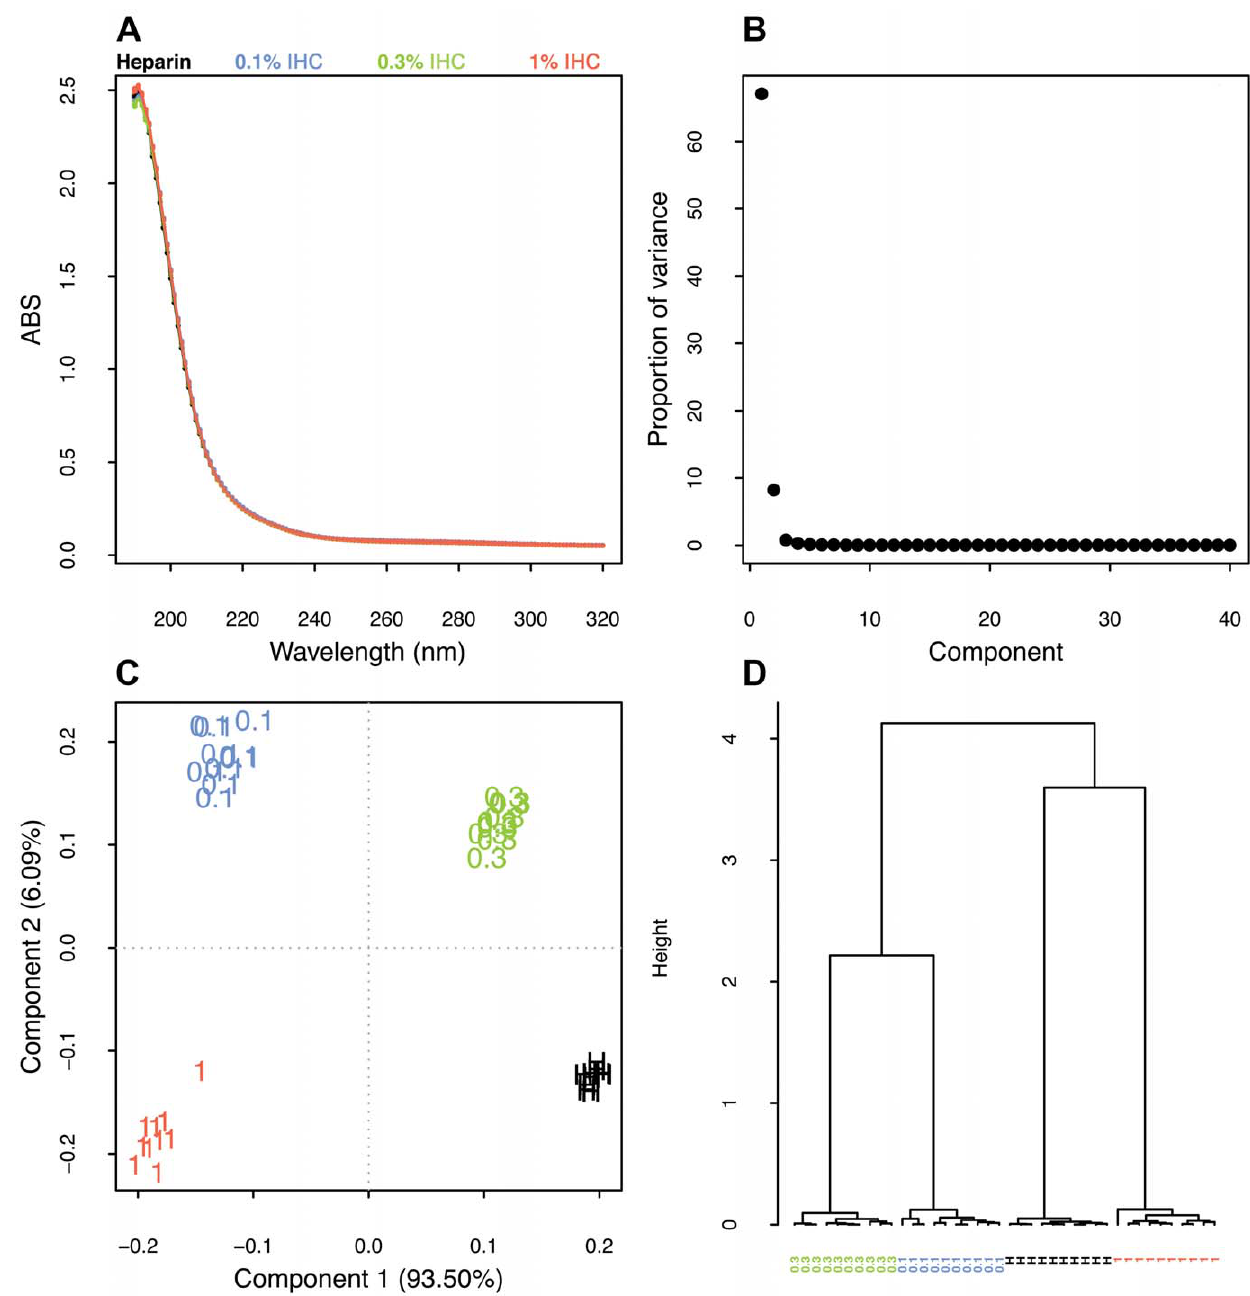
Figure 5. UV spectra, loading plot and Hierarchical cluster analysis of heparin preparations. ( A ) Overlay of heparin preparations UV-scan spectra. ( B ) Scree plot of components. ( C ) Component plot. ( D ) Hierarchical cluster analysis performed on the loading plot.